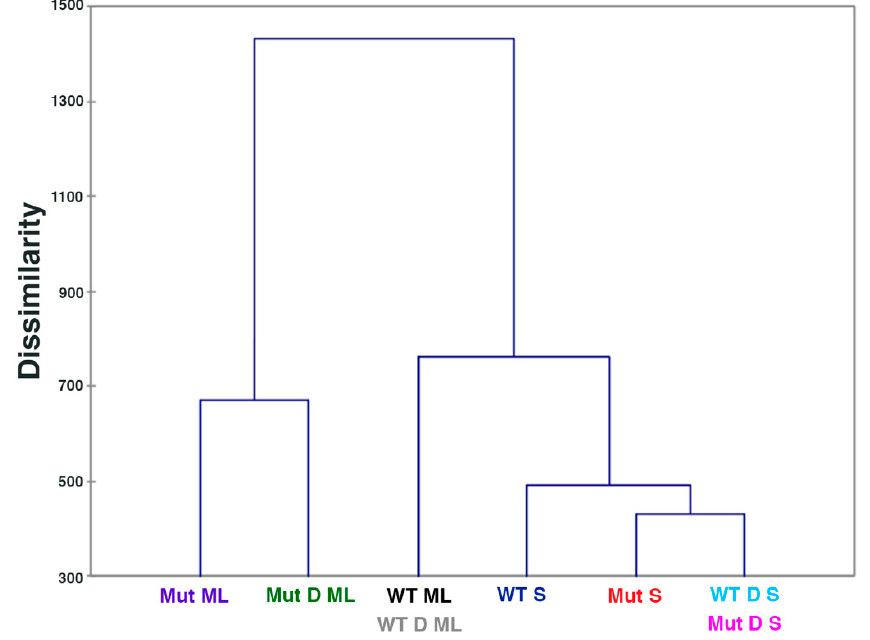
Figure 2. Hierarachical Clustering showing that WT ML and WT D ML cluster together, WT D S and Mut D S cluster together, and all other sample types are separate. Full names of sample groups are given in Table 1.